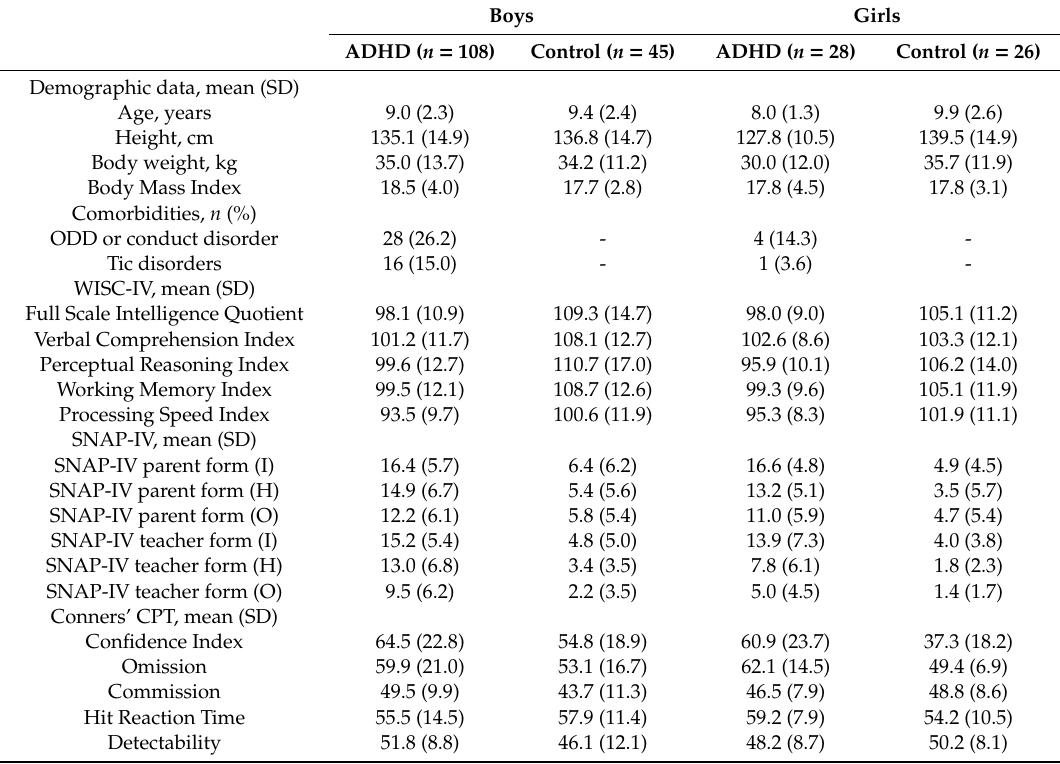
Table 1. Comparisons of demographic data and psychopathology evaluations in boys and girls among patients with ADHD and healthy